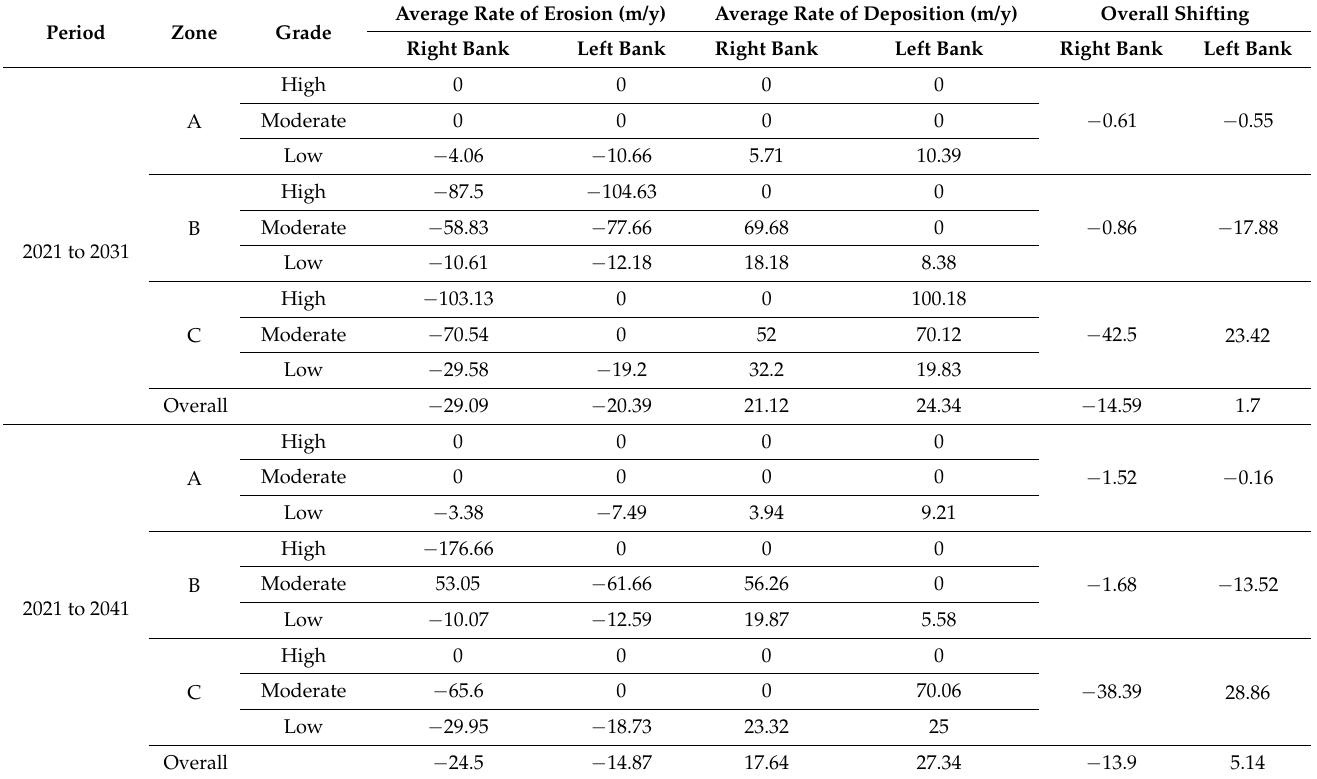
Table 6. Predicted bank shifting rate according to EPR for the periods of 2021 to 2031 and 2021 to